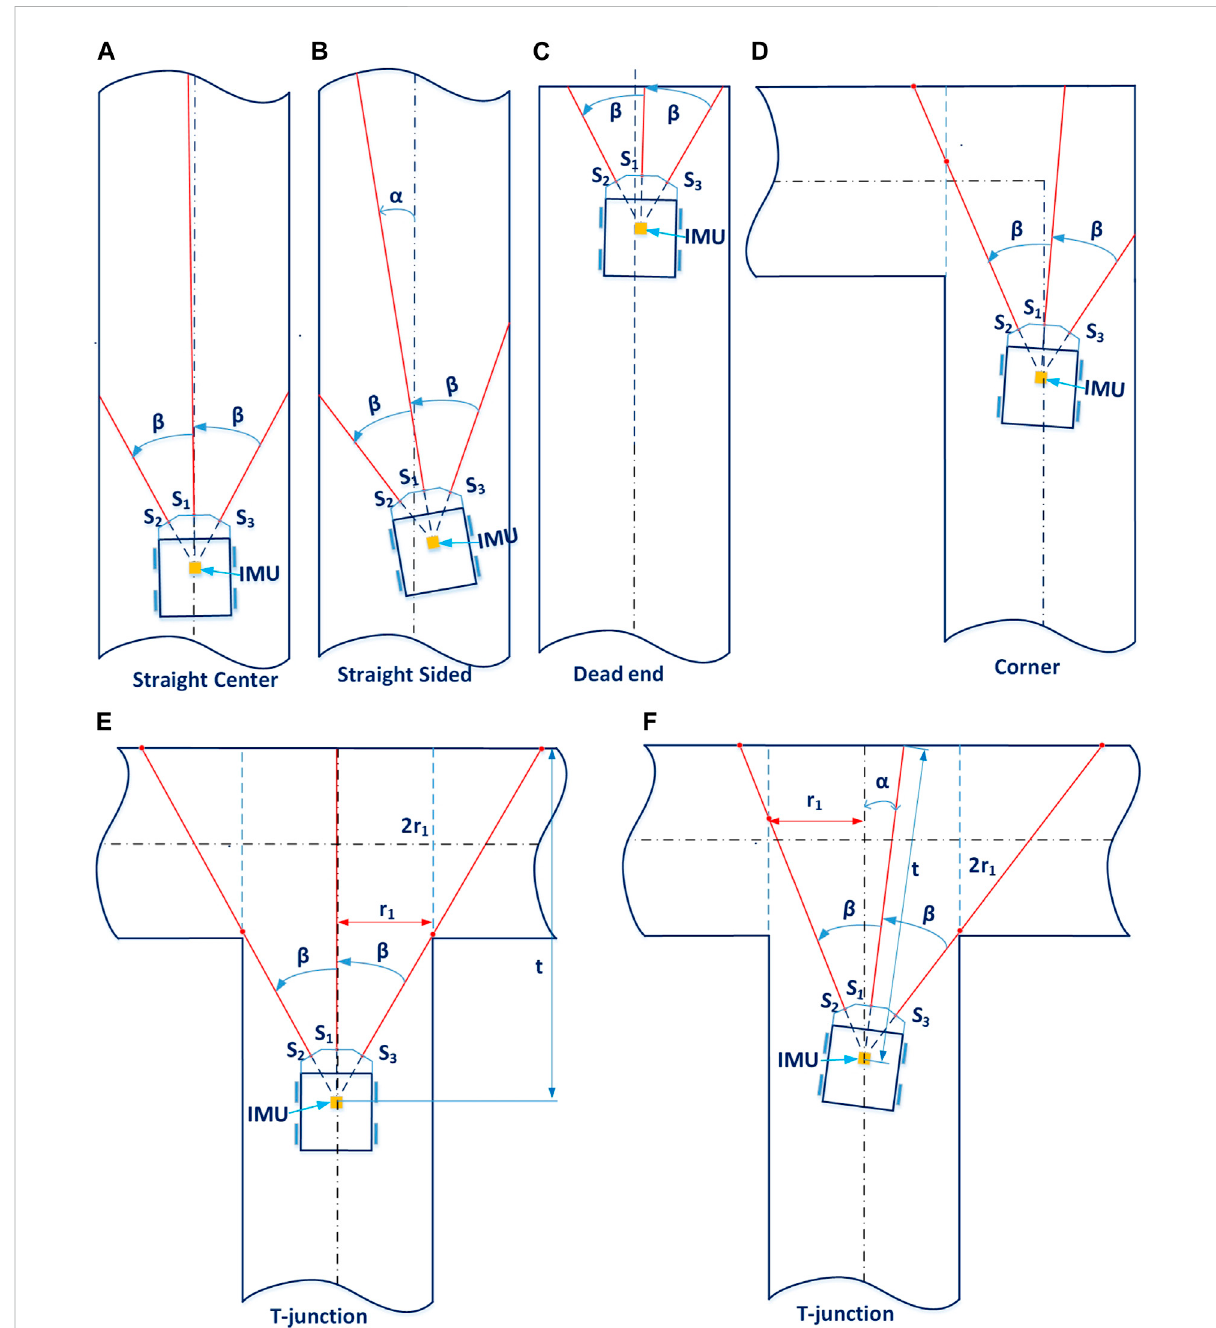
FIGURE 5 Junctionclassi fi cationusingrangesensors.Panel (A) andPanel (B) showtherobotinastraightpipe,withsimilarleftandrightrangevalues(these two states can be distinguished by checking the robot inertia data). Panel (C) illustrates a typical position of the robot when it detects a dead end (its frontrangevalueisunderacertainlimitandthesumvalueofitsthreerangesensorsisunderade fi nedlimit).Panel (D) showstherobotapproachinga corner.Asitsleftrangevalueissigni fi cantlyhigherthantheexpectedvalueofthestraightpipecase,itcandeterminethereisaleftcorner.Panel (E) and Panel (F) show the robot approaching aT-junction ata straight angle ( α = 0,PanelE) orat asmall angle ( α > 0,Panel F). Bychangingthissmall angle α , we can determine the minimum and maximum distance d A (i.e., T_ASSESSING_DIS_MIN and T_ASSESSING_DIS_MAX ) to assess if the robot is approaching a T-junction or